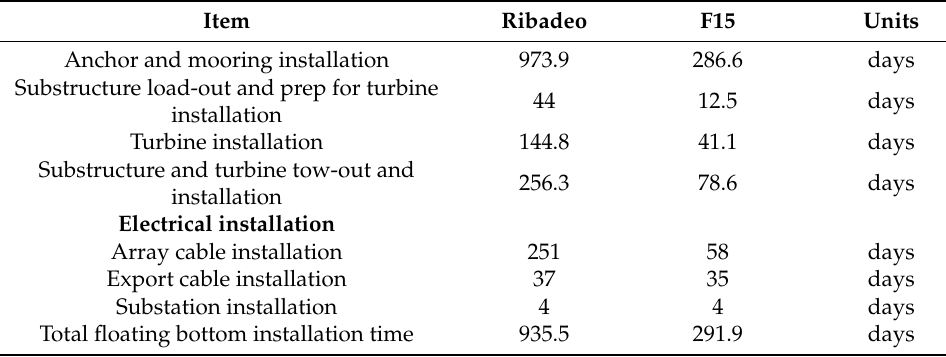
Table 7. Main components installation